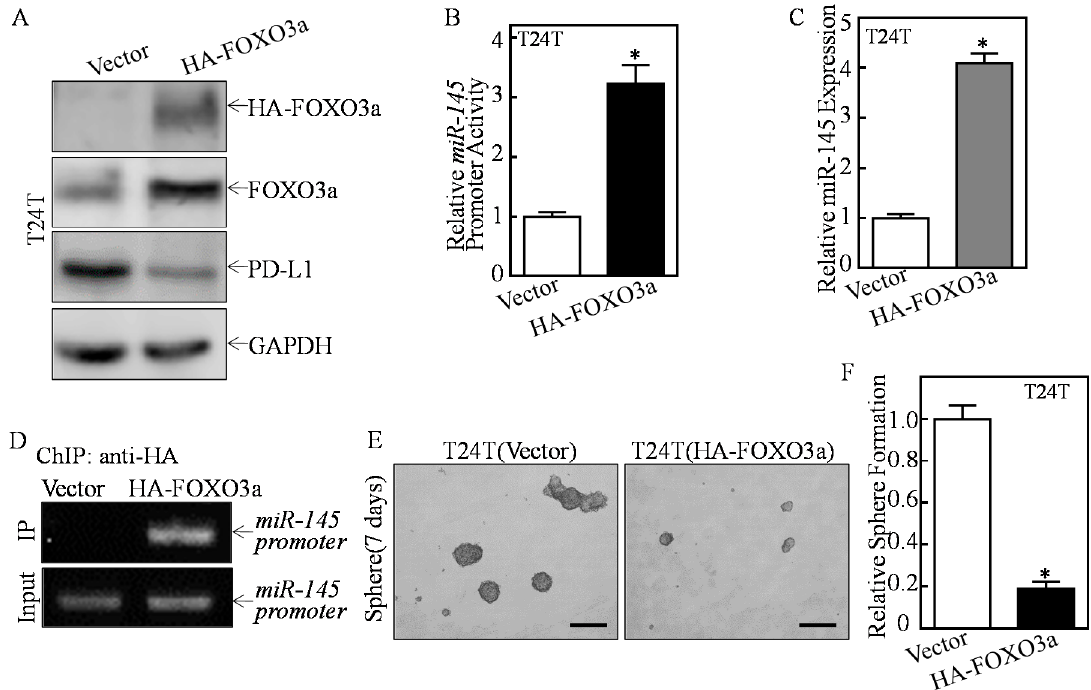
Figure 5. FOXO3a was an ATG7-regulated transcription factor mediating miR-145 downregulation in human BCs. ( A ) HA-tagged FOXO3a construct was stably transfected into T24T cells. The FOXO3a overexpression efficiency and its downstream PD-L1 expression were assessed by Western Blot. GAPDH was used as a protein loading control. ( B , C ) The miR-145 promoter-driven luciferase reporter together with TK reporter was transfected into the indicated cells. Luciferase activity of each transfectant and miR-145 expression were evaluated and the bars show mean ± SD from three independent experiments. The asterisk (*) indicates a significant increase as compared with Vector transfectant (* p < 0.05). ( D ) 1 × 10 6 T24T cells were seeded into 10-cm dish. After the cell density reached 80–90%, ChIP assay was performed with anti-FOXO3a antibody to determine FOXO3a binding to the motifs between − 779 and − 600 bp of the miR-145 promoter. ( E , F ) The indicated cells were subjected to determination of sphere formation abilities according to the manufacturer’s instruction, the number of spheroid formed cells were counted as described in the Materials and Methods section. The asterisk (*) indicates a significant decrease in comparison to scramble Vector transfectant (* p < 0.05). Scale bars in ( E ) = 200 µ